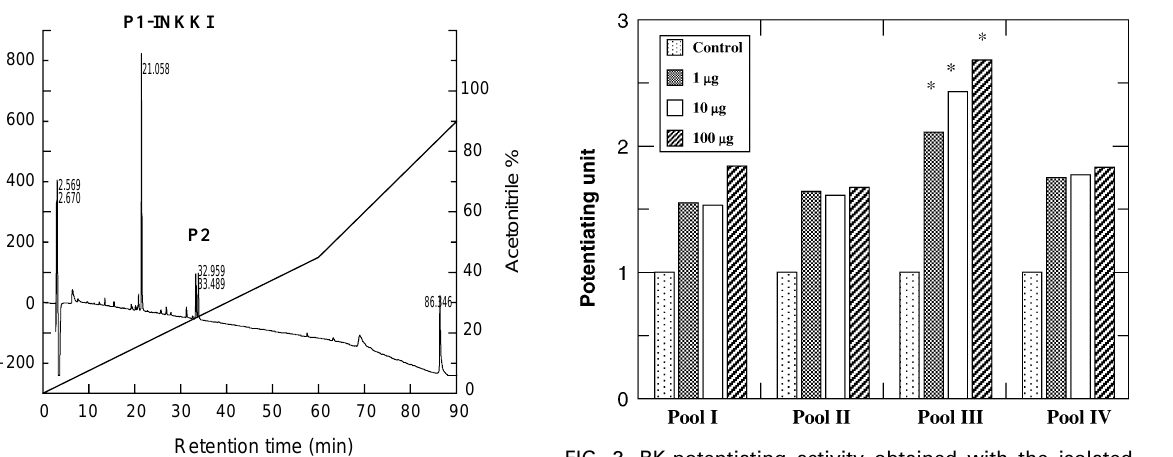
FIG. 3. BK-potentiating activity obtained with the isolated pools (I, II, III and IV) from a Sephadex G-10 column in the isolated guinea pig ileum. The potentiating-activity (PU) was calculated as described in Methods. Only pool III showed significant differences when compared with controls (Student t-test, *p B / 0.05).